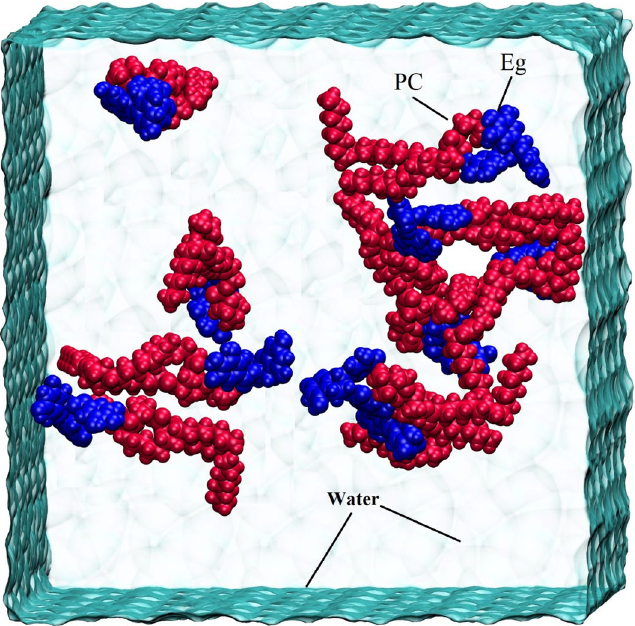
Figure 3. The initial snapshot of for Eg-PC system as a representative model of the designed MD simulation